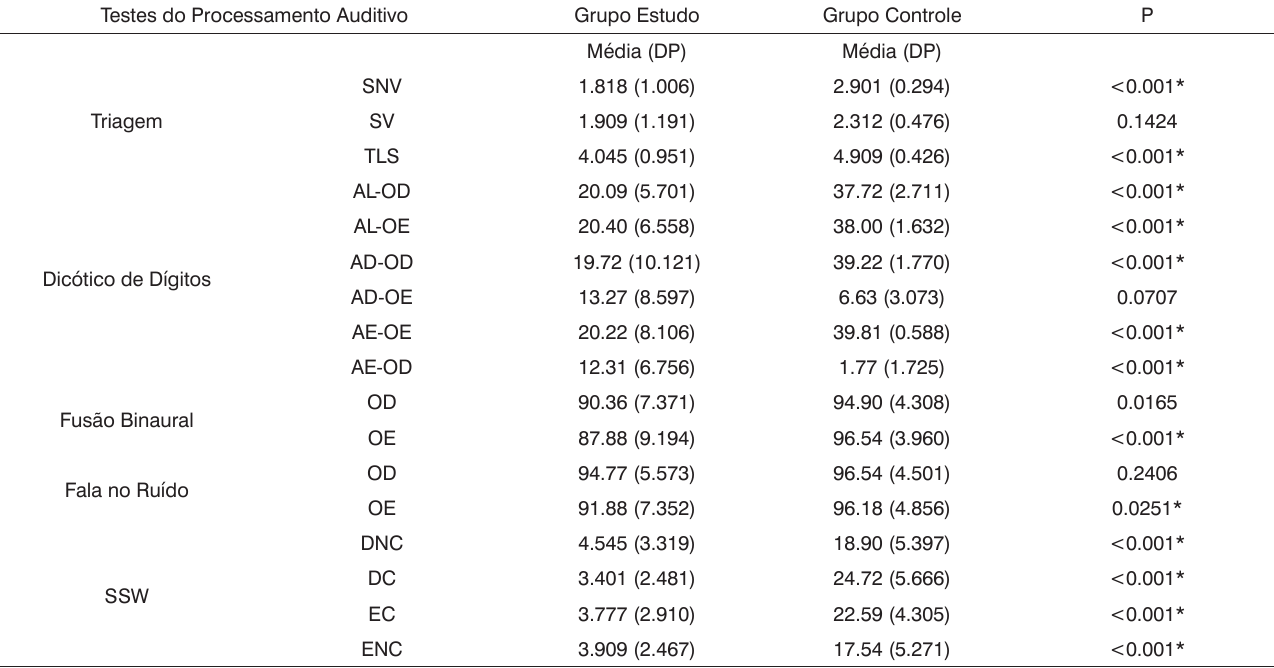
Testes do Processamento